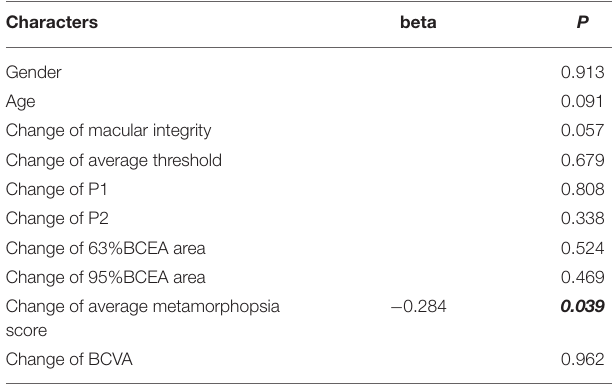
TABLE 8 | Multiple linear regression model to evaluate the factors associated with the change of VR-QoL